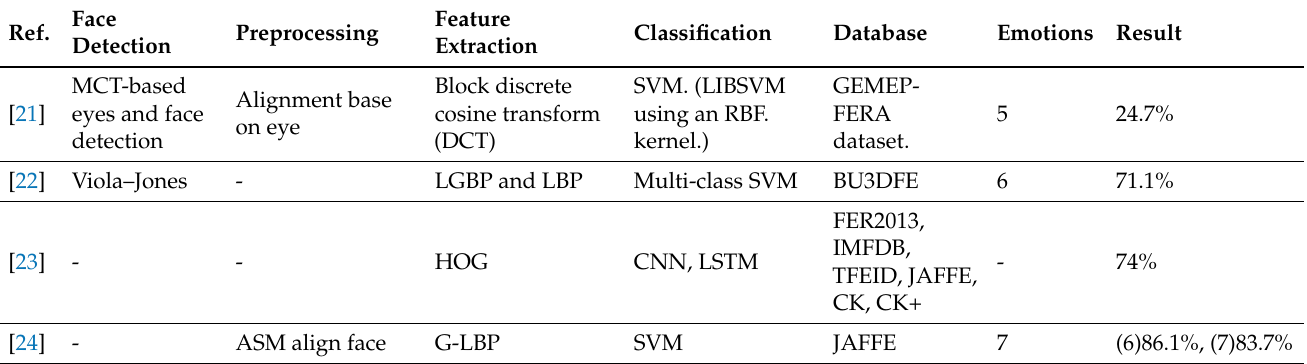
Table 1. Summary of discussed works along with a different combination of face detection, feature- extraction techniques, and